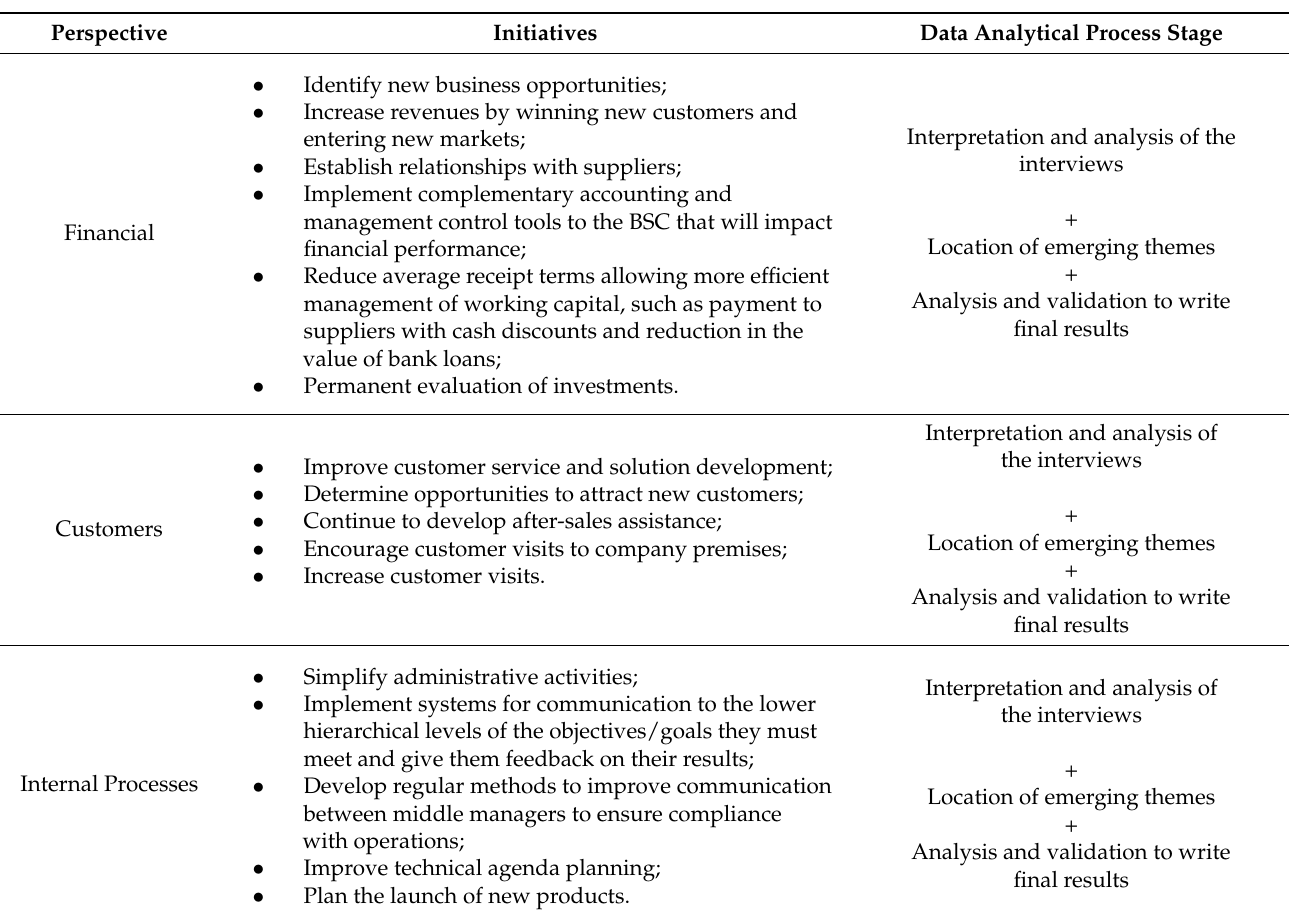
Table 3. Identification of